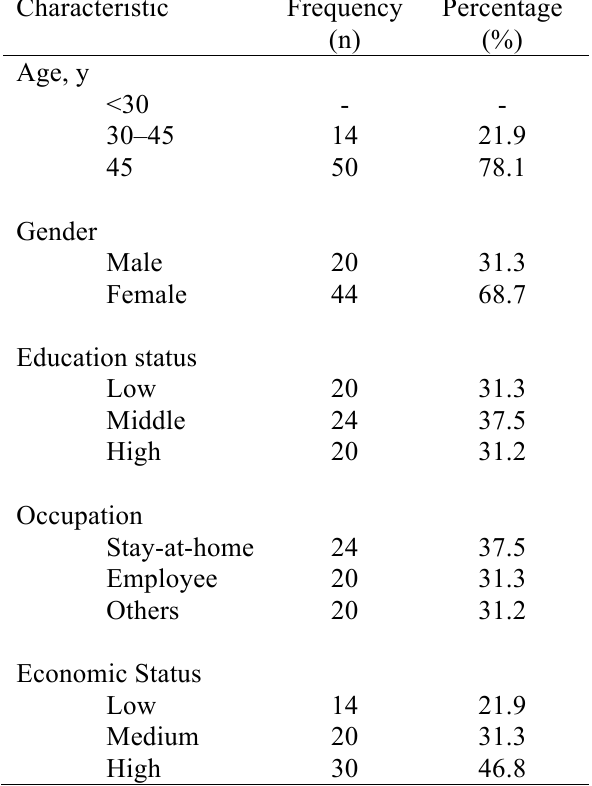
Table 1 Characteristics of the subjects